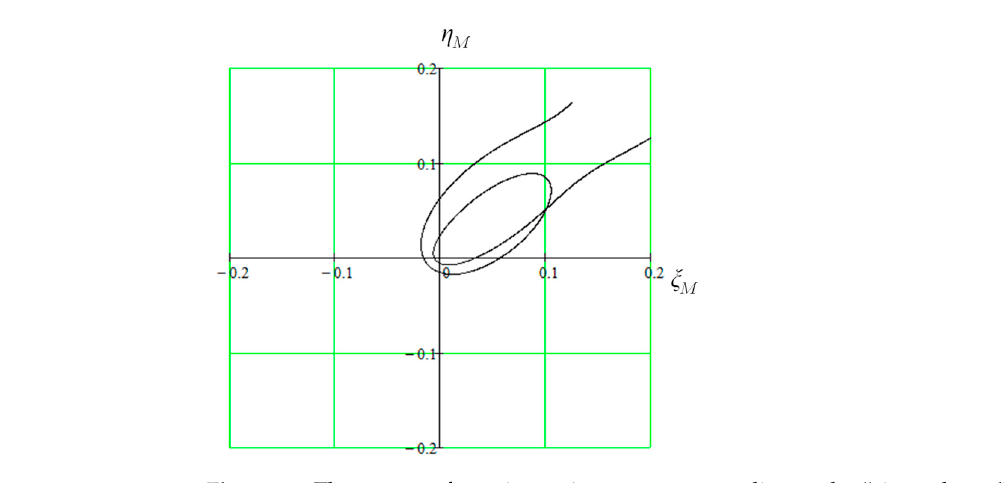
Figure 20. The spacecraft motion trajectory corresponding to the “circumlunar” segment (starting from time t 1 to t 1 + (cid:101) ∆ t f ). The shown fragment (on an enlarged scale) gives a clear idea of the rate of evolution of a closed osculating orbit.